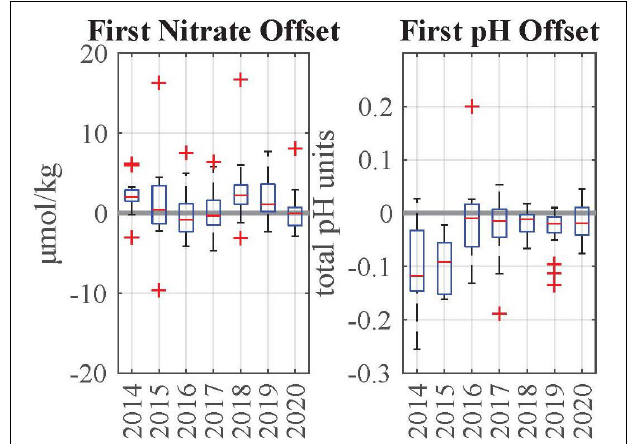
FIGURE 11 | Boxplot summaries of first nitrate (left) and first pH (right) offsets, grouped by deployment year. Red lines represent the median, box boundaries represent the interquartile range (Q3–Q1), whiskers are the outer range of data, excluding outliers (red + ) which are defined as data points that are larger than Q3 + 1.5 × (Q3 – Q1) or smaller than Q1 – 1.5 × (Q3 –